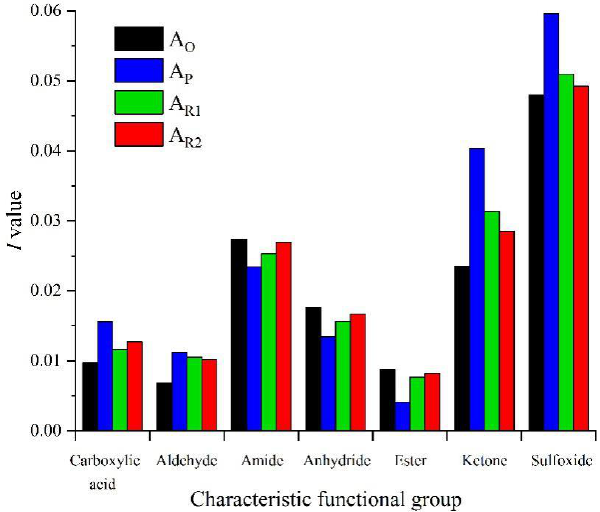
Figure 12. Change rule of aging coefficient of each group.